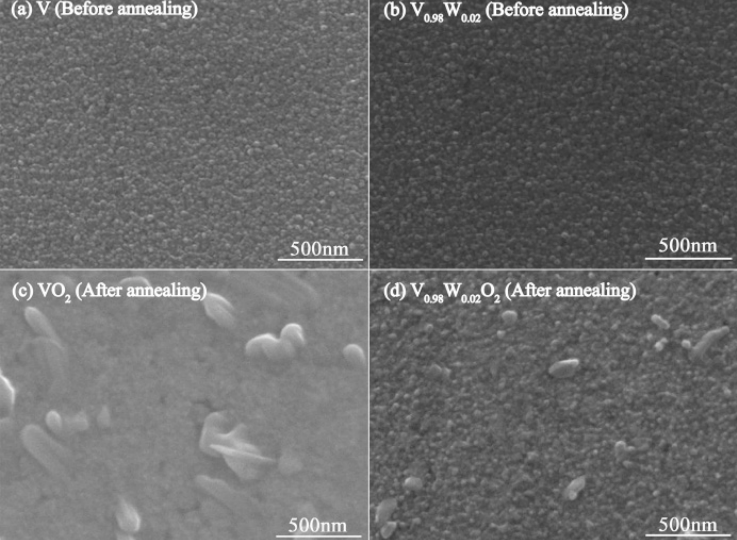
Figure 2. SEM surface micrographs of pure and 2% W-doped V films before and after annealing. ( a ) Pure V film before annealing. ( b ) 2% W-doped V film before annealing. ( c ) Pure V film after annealing. ( d ) 2% W-doped V film after annealing. The films were sputtered with the power of 500 W: 0 W and 0 W: 500 W for the pure and 2% W-doped V targets without heating, respectively. They were annealed at 530 °C for 30 min with oxygen pressure of 18 Pa.